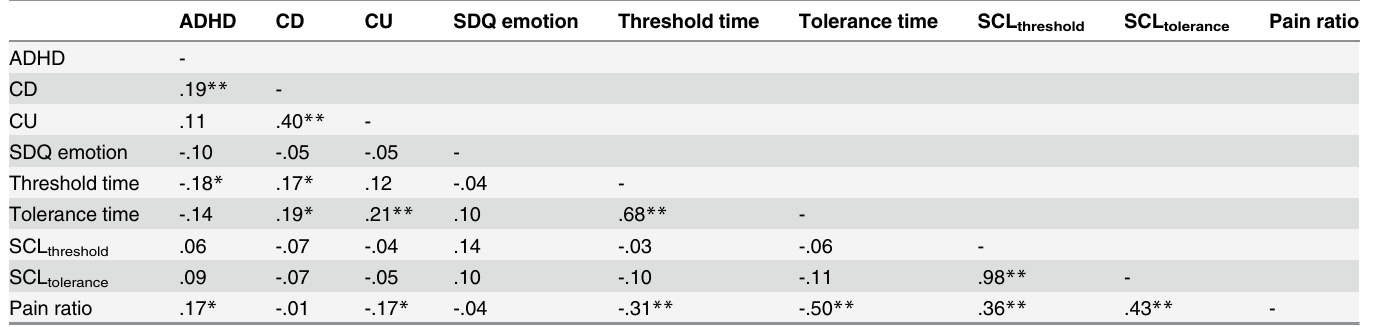
Table 2. Pearson ’ s correlations between clinical and pain sensitivity